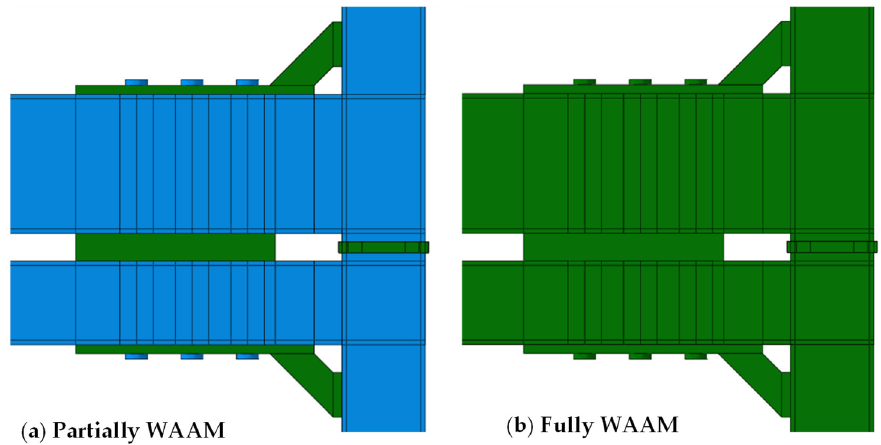
Figure 7. 3D printed components (illustrated in green colour) in WAAM modular connection [28] .